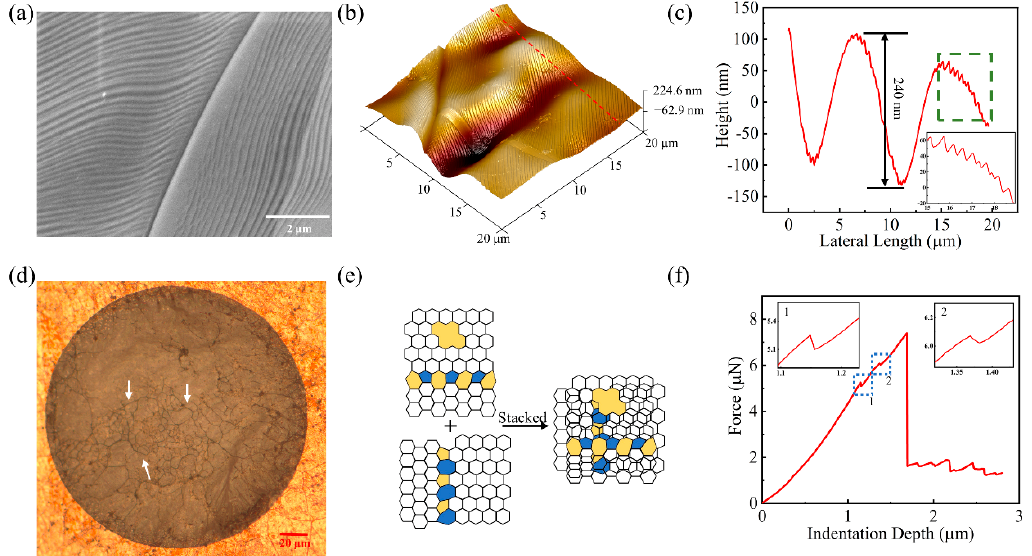
Figure 5. ( a ) SEM image, ( b ) AFM 3D image and ( c ) AFM line pro fi le of the surface of a Cu foil with CVD-grown monolayer graphene fi lm on top. Inset in ( c ) is an enlarged view of the dashed area. ( d ) Optical microscope image of stacked suspended graphene. ( e ) Scheme of stacking graphene fi lm with defects between di ff erent layers. ( f ) Typical nanoindentation fracture curves of suspended stacked graphene fi lm, and the inset is an enlarged view of the dashed region.